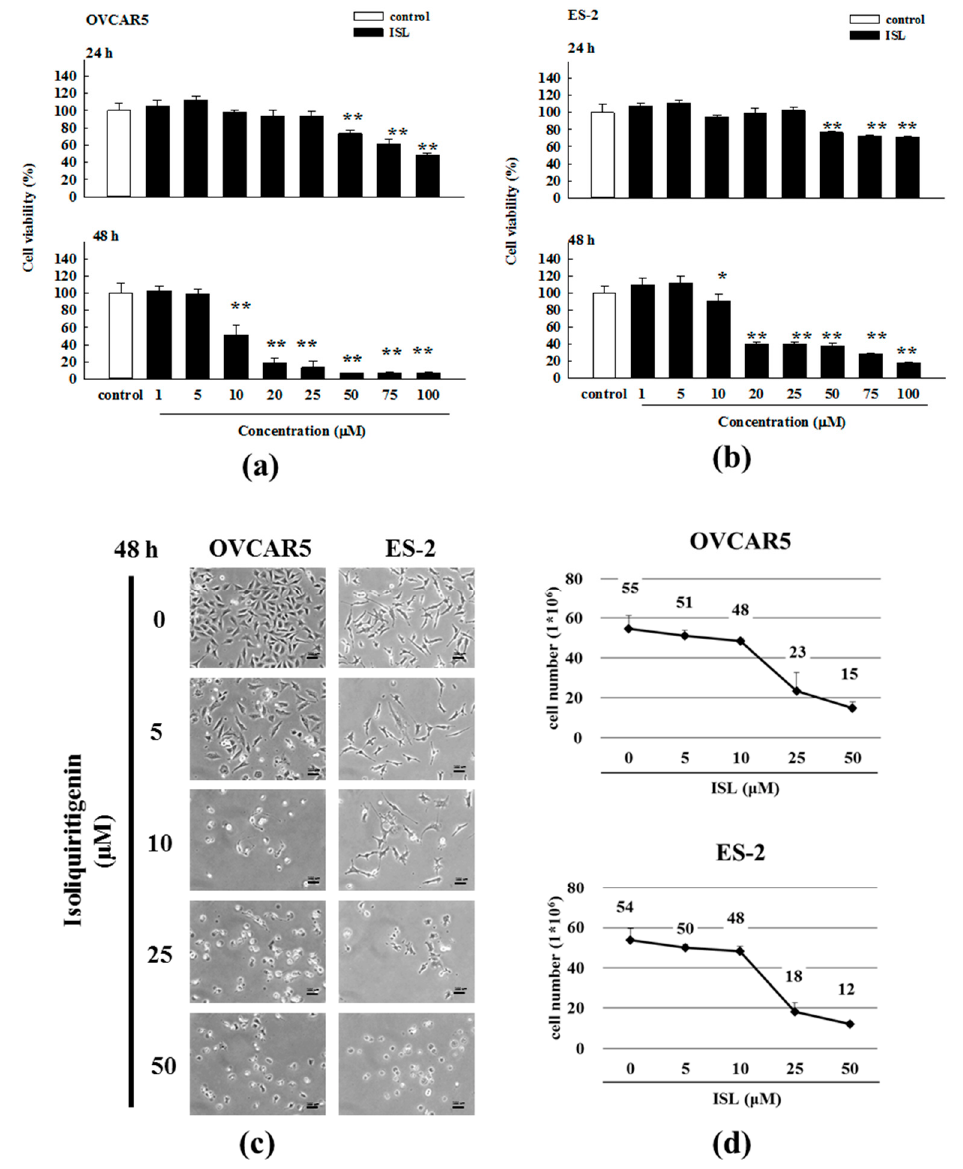
Figure 1. Cytotoxicity of isoliquiritigenin on ovarian cancer cells. ( a ) OVCAR5 and ( b ) ES-2 cells were exposed to control (dimethyl sulfoxide, DMSO) and the indicated concentration of ISL from 1 to 100 µ M follow by 24–48 h incubation. Cell proliferation was measured by MTS assay; ( c ) The morphology of OVCAR5 and ES-2 cells after treated with control (DMSO) and 5, 10, 25, and 50 µ M of ISL in media containing 1% FBS for 48 h. Bars equal to 100 µ m; ( d ) Number of viable cells after treated with control (DMSO) and 5, 10, 25, and 50 µ M of ISL in media containing 1% fetal bovine serum (FBS) for 48 h. Cell viability was determined by trypan blue exclusion test. The results are expressed as means ± SD of three independent experiments. * p < 0.05 and ** p < 0.001 compared with control.